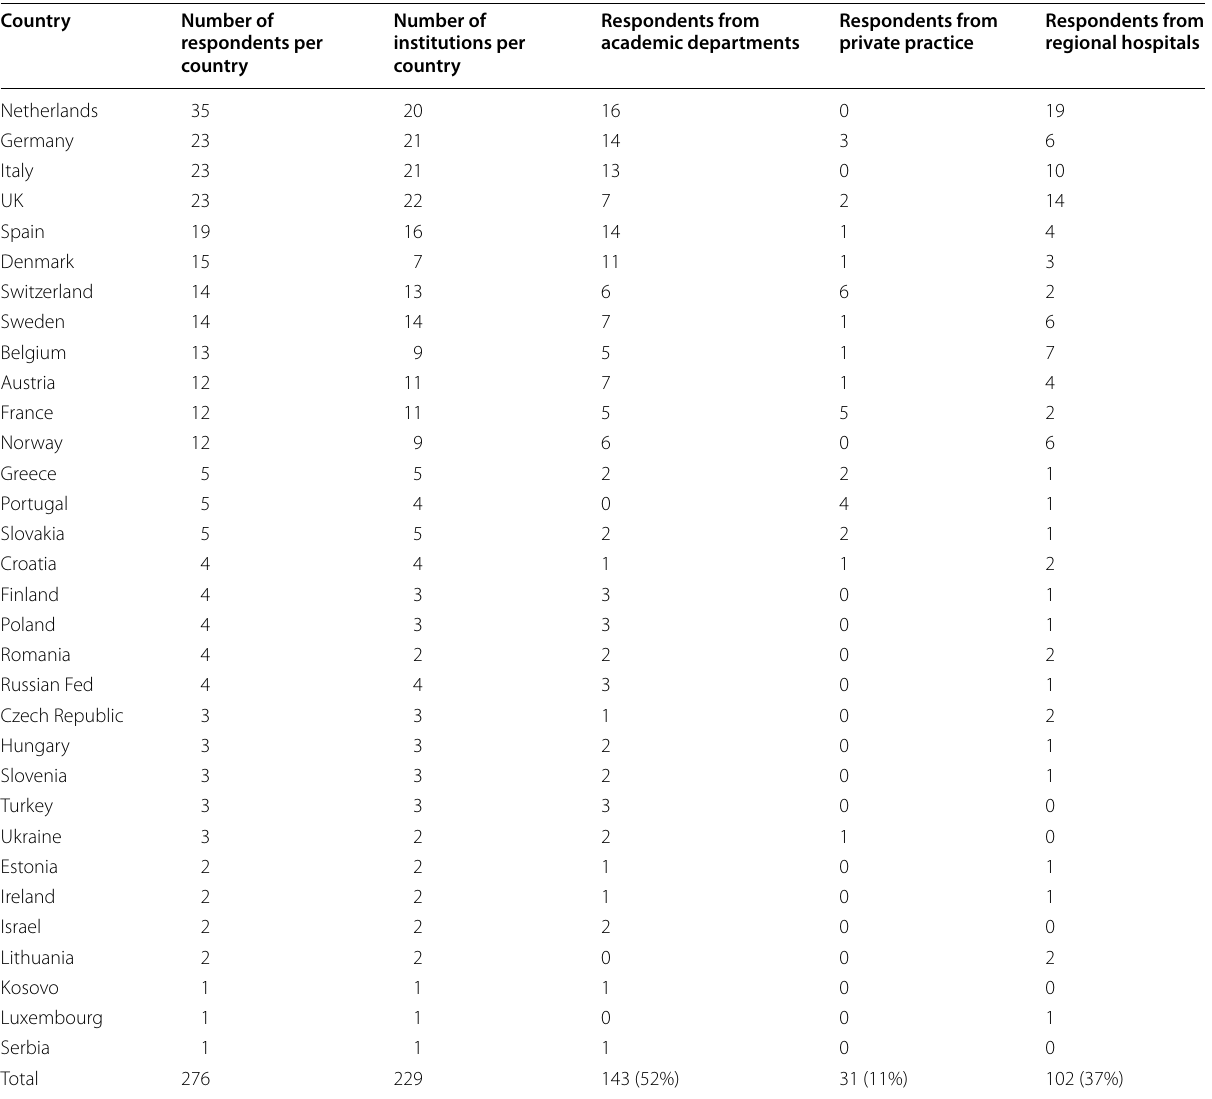
Table 2 Respondents with practical clinical experience with AI-based algorithms: distribution of origin by countries and type of